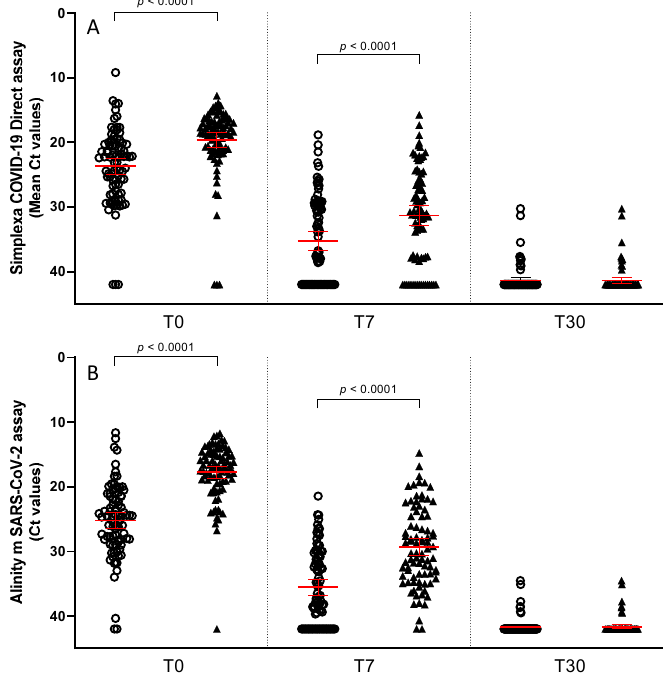
Figure 2. Cycle threshold values of SARS-CoV-2 RNA in 85 saliva and NPS samples at T0, T7 and T30 after pharmacological treatment. Ct values obtained in saliva samples are represented with circles, while those obtained in NPS are represented with triangles. Median Ct values with 95% of Confidence Interval are indicated with red lines. Statistically significant differences were found in Ct values of the two matrices either T0 or T7 by paired T-test both using Simplexa ( A ) and Alinity ( B ) platforms.